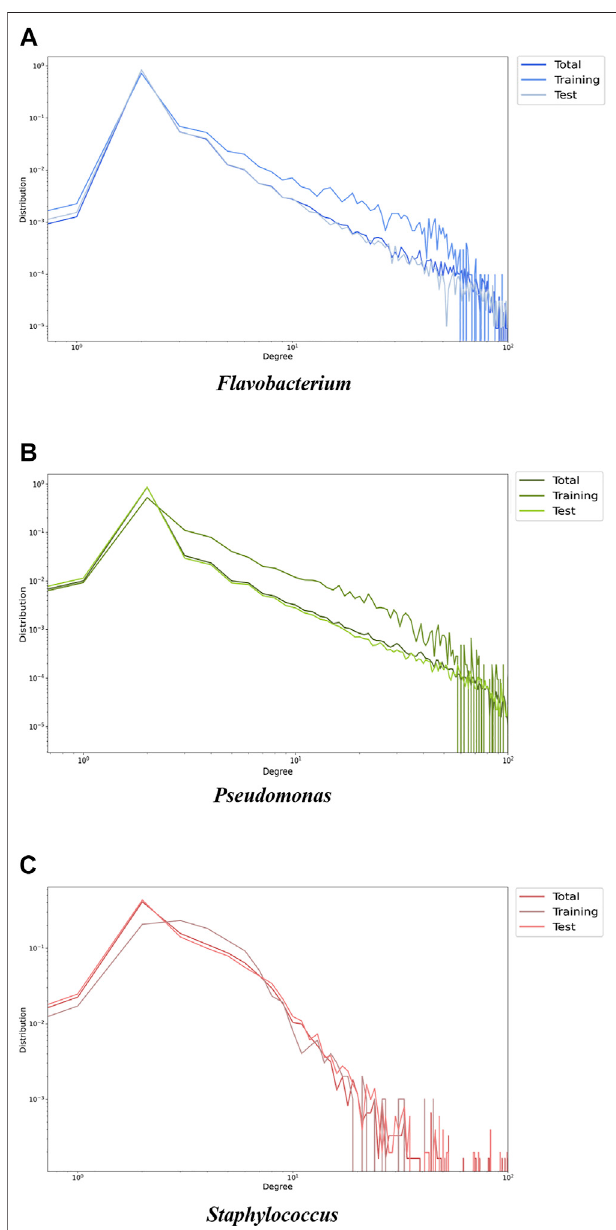
FIGURE 7 | Degree distribution curves describing the degree distributions of the overall network, the training set network and the test set network for each of the three genera [ (A) Flavobacterium, (B) Pseudomonas (C) Staphylococcus ]. The horizontal axis is the degree (truncated to 100), and the vertical axis is the probability distribution (The sum of the probabilities is 1). The results show that the degree distributions of the initial training set and the test set for the three genera are different, re fl ecting the genome characteristics of each genus to a certain extent.